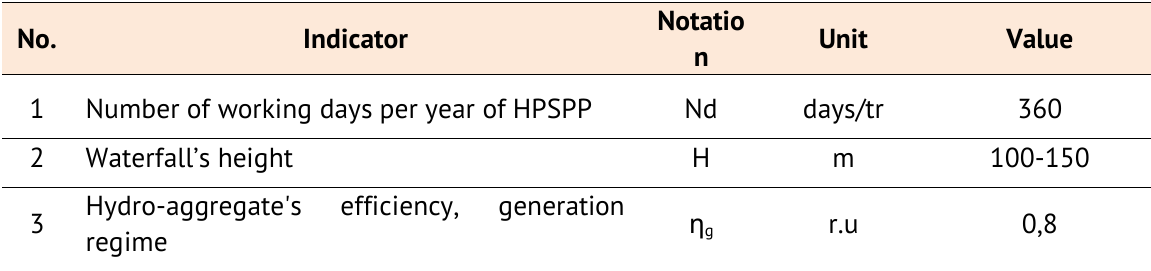
Data underlying the